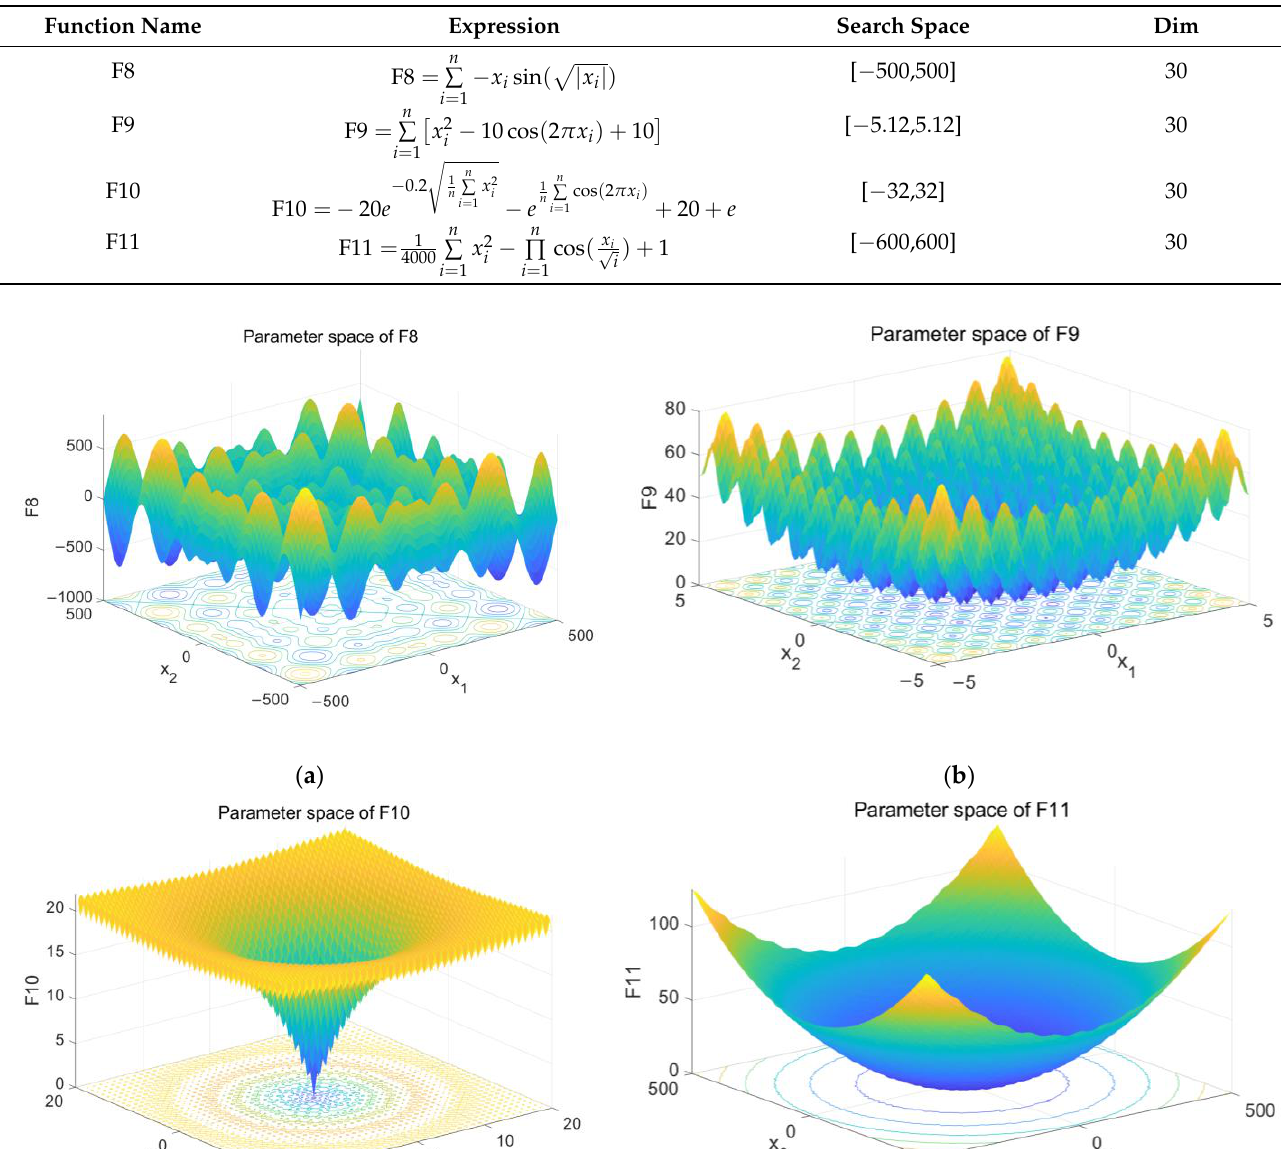
of F9 and ( c ) the parameter space of F10 and ( d ) the parameter space of F11.